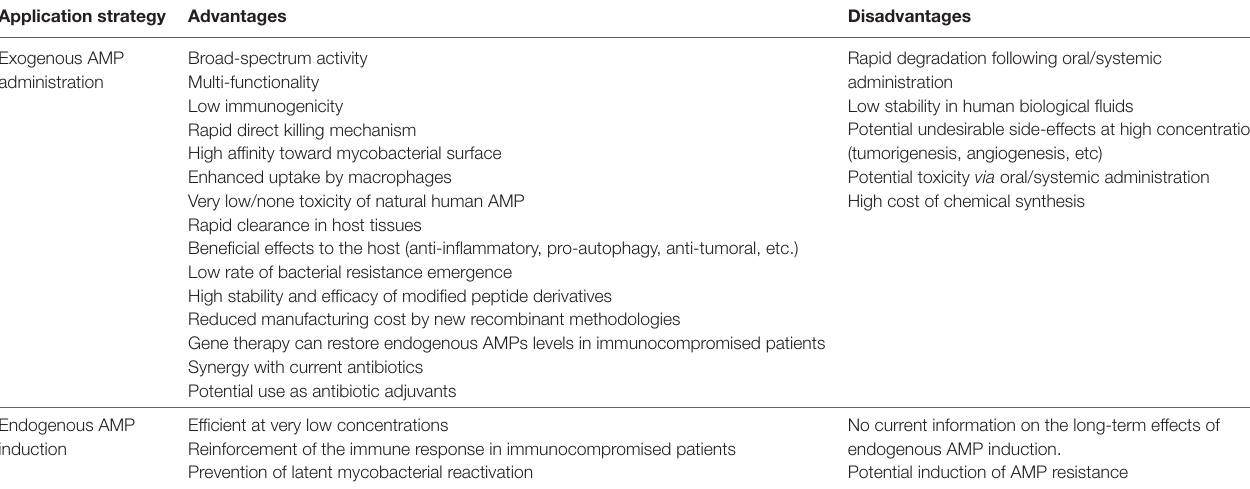
TABLe 4 | Human anti-TB AMP therapy: advantages and disadvantages. Application strategy Advantages